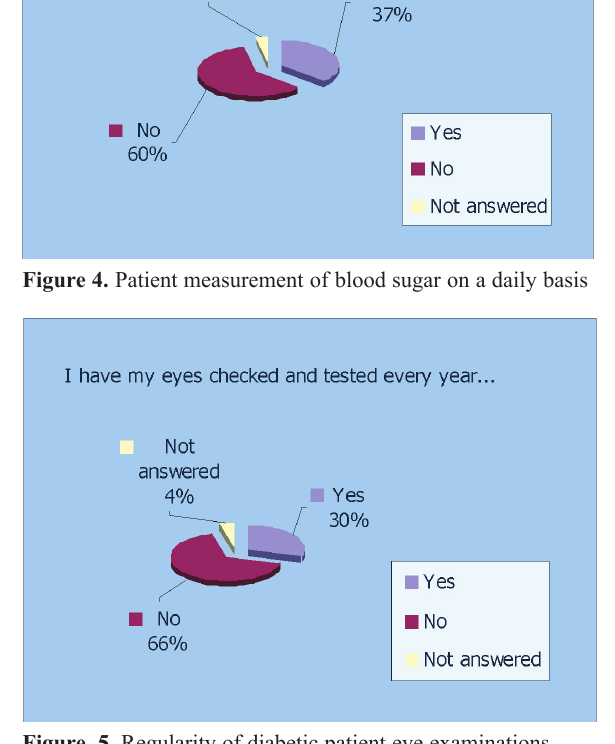
Figure 5. Regularity of diabetic patient eye